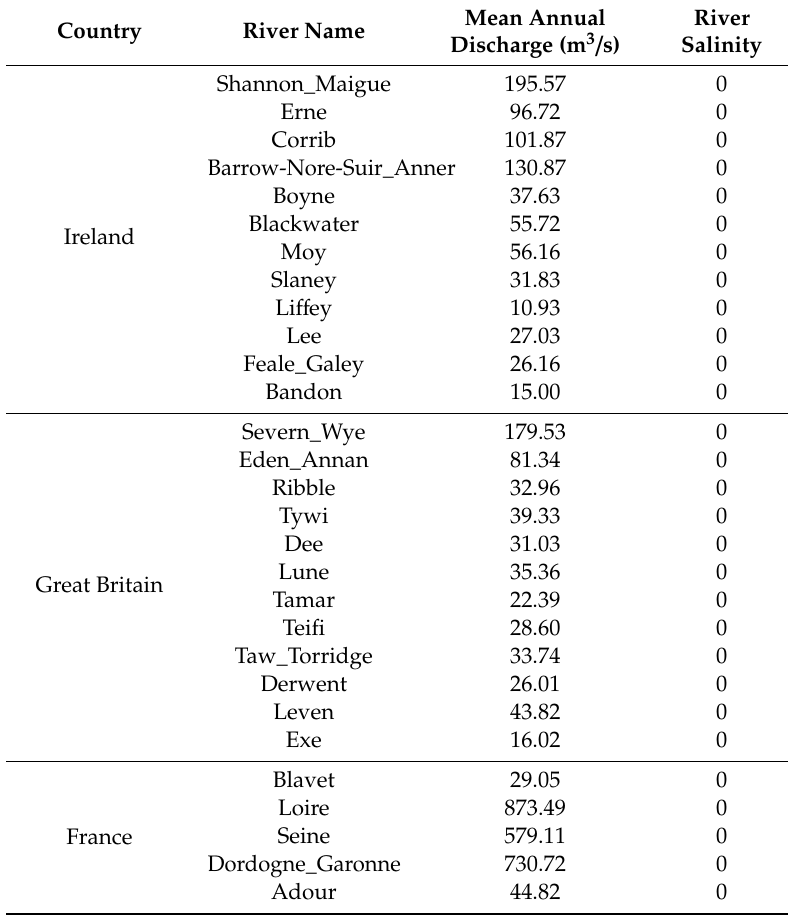
Table 1. Mean annual climatological river discharge values (m 3 / s) included in the NEA_ROMS. Country River